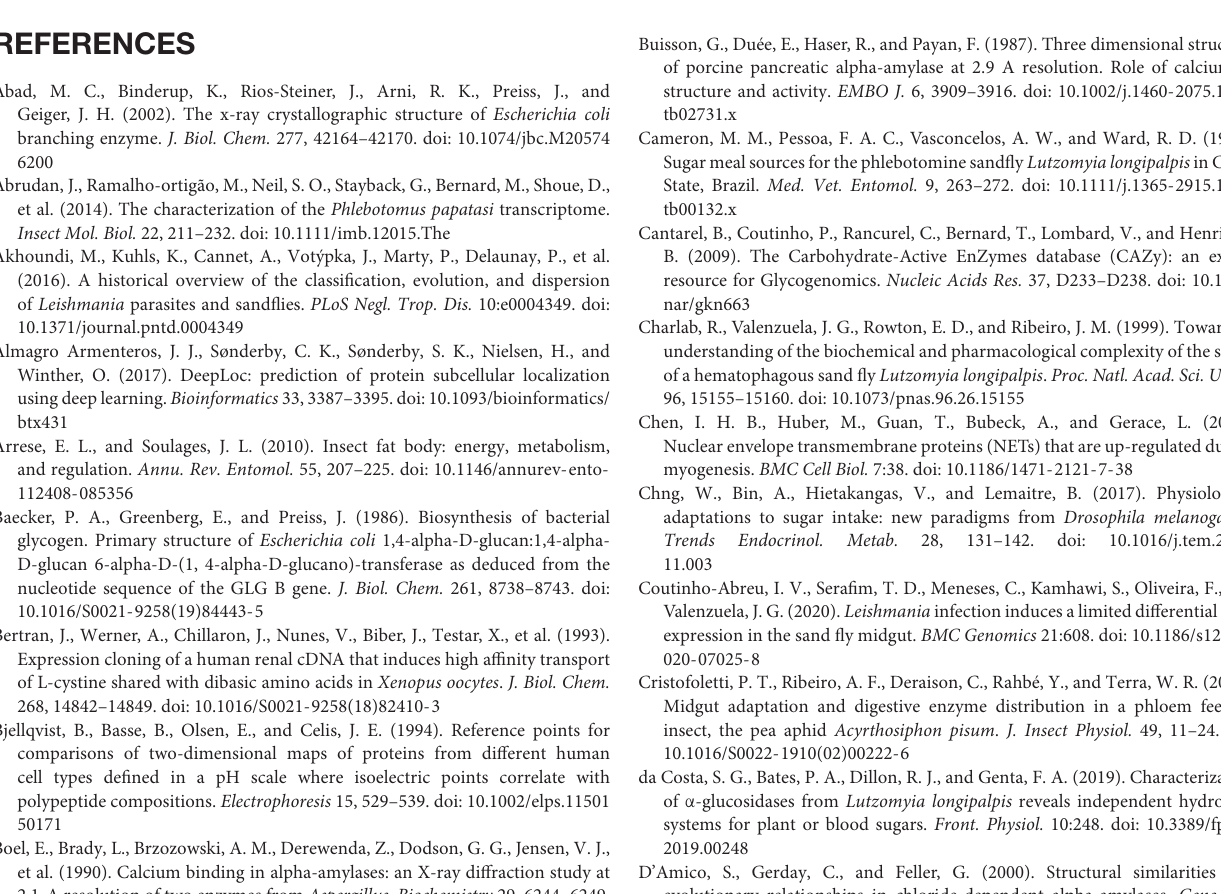
Supplementary Table 4 | Modifications on sequences from GH13 and GH31 retrieved from vector base. Supplementary Table 5 | Manual annotation of L. longipalpis GH13 sequences retrieved from Vector Base ( L. longipalpis , Jacobina strain, LlonJ1.4 geneset, June 2017). Sequences were considered complete when initial methionine, correct exon/intron junction, stop codon were identified, and exon structures were complete based on homology with orthologous genes. For incomplete proteins some N and O-glycosylation sites are missing. In transmembrane proteins, only extracellular domains were considered to be N-glycosylated. Non-canonical catalytic residues are highlighted. ND, Not Determined. Supplementary Table 6 | Manual annotation of L. longipalpis GH31 sequences retrieved from Vector Base ( L. longipalpis , Jacobina strain, LlonJ1.4 gene set, June 2017). Sequences were considered complete when initial methionine, correct exon/intron junction, stop codon were identified, and exon structures were complete based on homology with orthologous genes. For incomplete proteins some N and O-glycosylation sites are missing In transmembrane proteins, only extracellular domains were considered as N-glycosylated. Non-canonical catalytic residues are highlighted. ND, Not